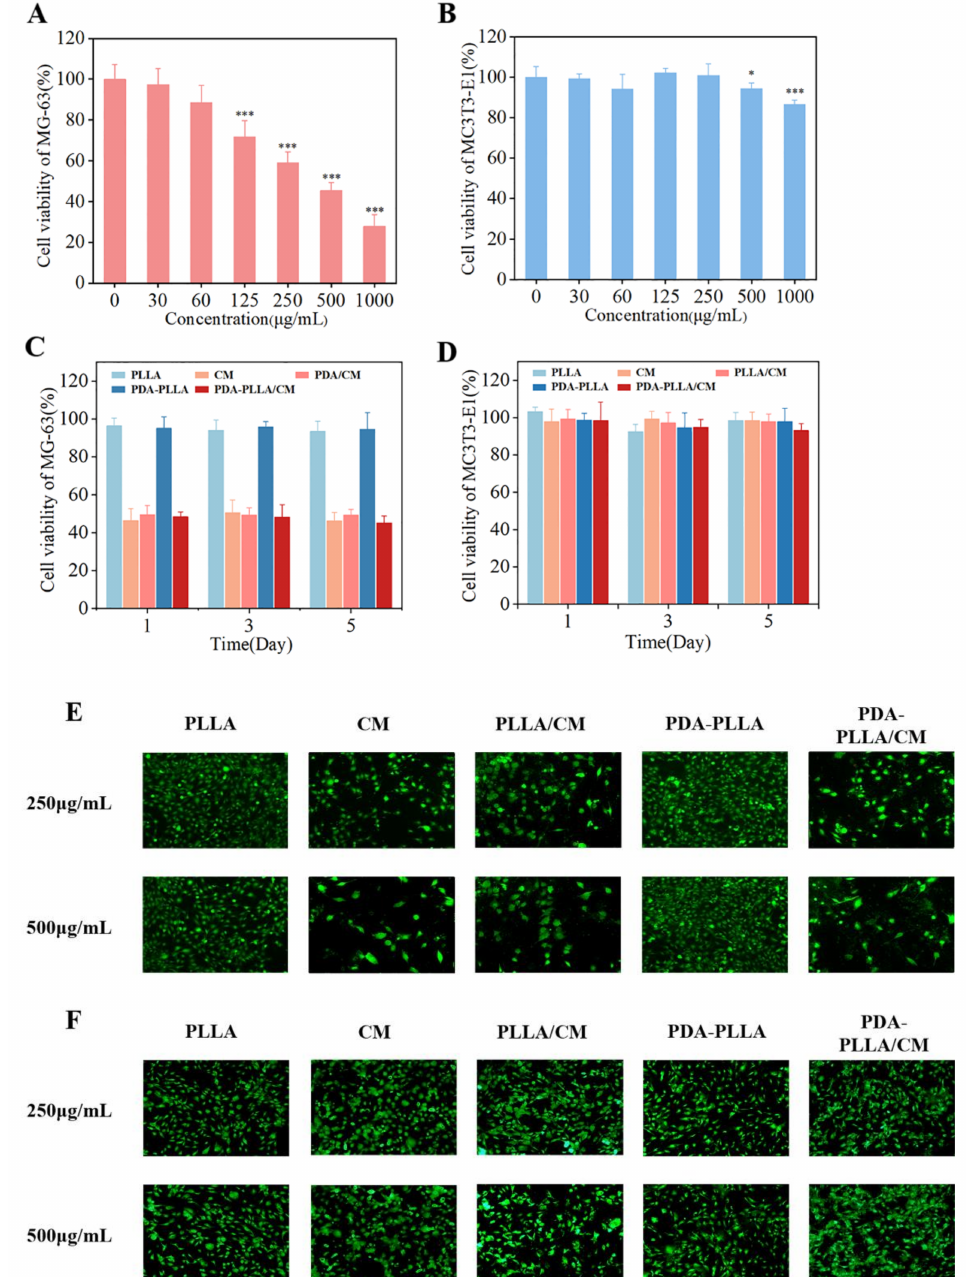
Figure 5. ( A , B ) Cell viability after being co-cultured with PDA-PLLA/CM microparticles at dif- ferent concentrations for 48 h. ( C , D ) After being treated with different samples for 1, 3, 5 days. ( E , F ) Fluorescence staining images of MG-63 and MC3T3-E1 cells incubation with different samples. (PLLA, PLLA/CM, PDA-PLLA and PDA-PLLA/CM microparticles, 500 µ g/mL; CM, 75 µ g/mL). (* p -value < 0.05, *** p -value <